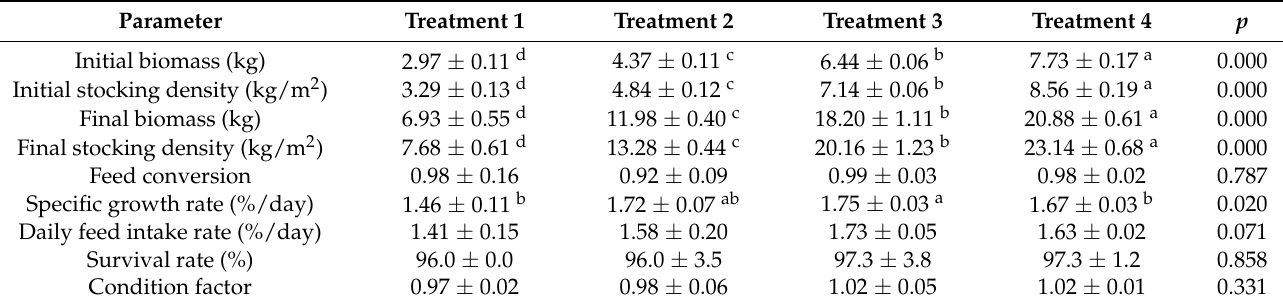
Table 3. Growth performance of olive flounder Paralichthys olivaceus cultured at four different initial stocking densities for 8